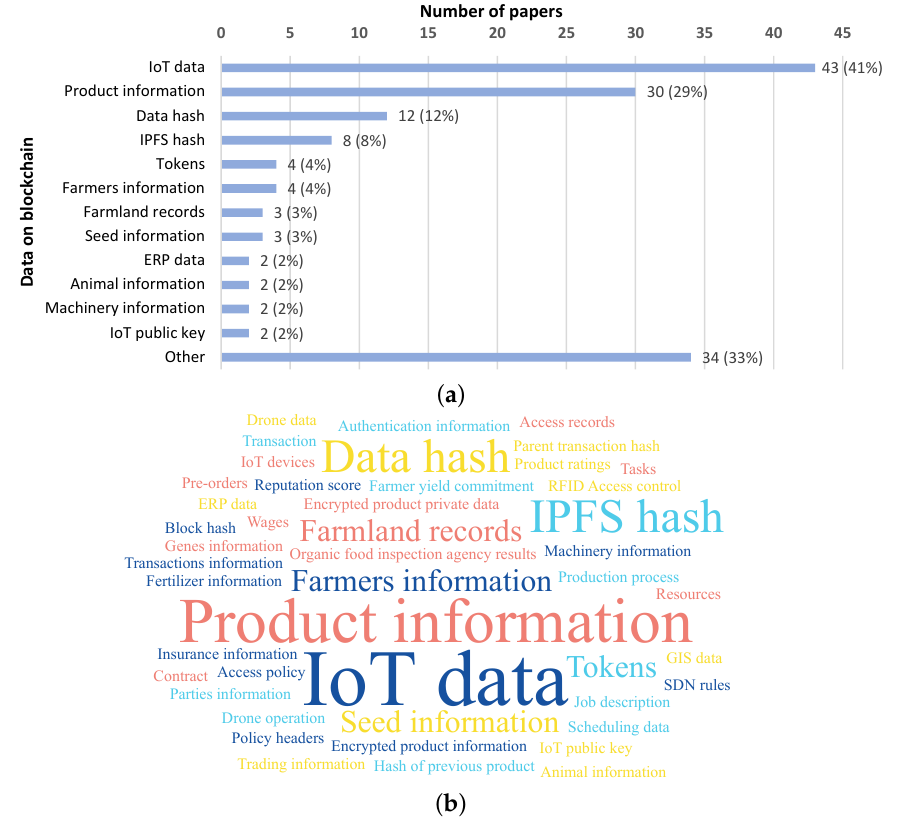
Figure 11. Types of data stored in the blockchain in the papers included in our scoping review.